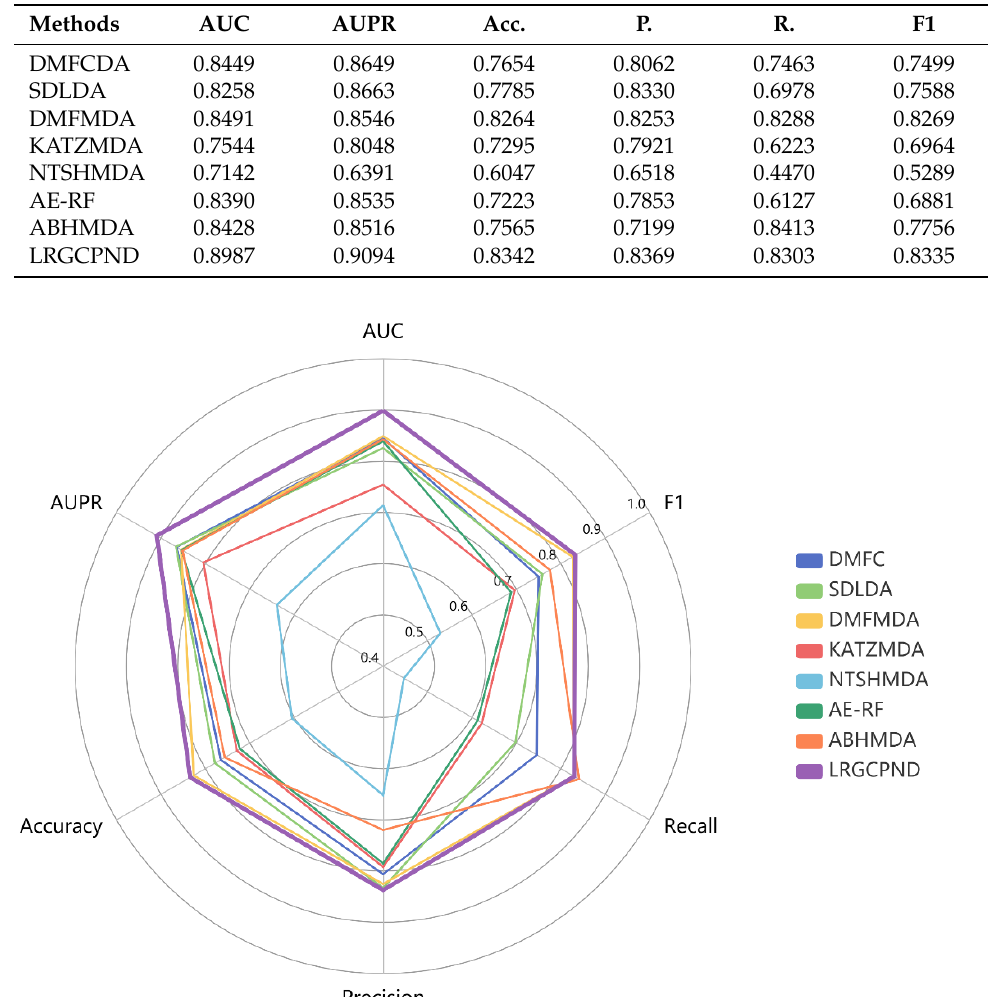
Figure 5. ROC curves of different methods on our dataset. Table 4. Prediction results of different methods in five-fold CV.